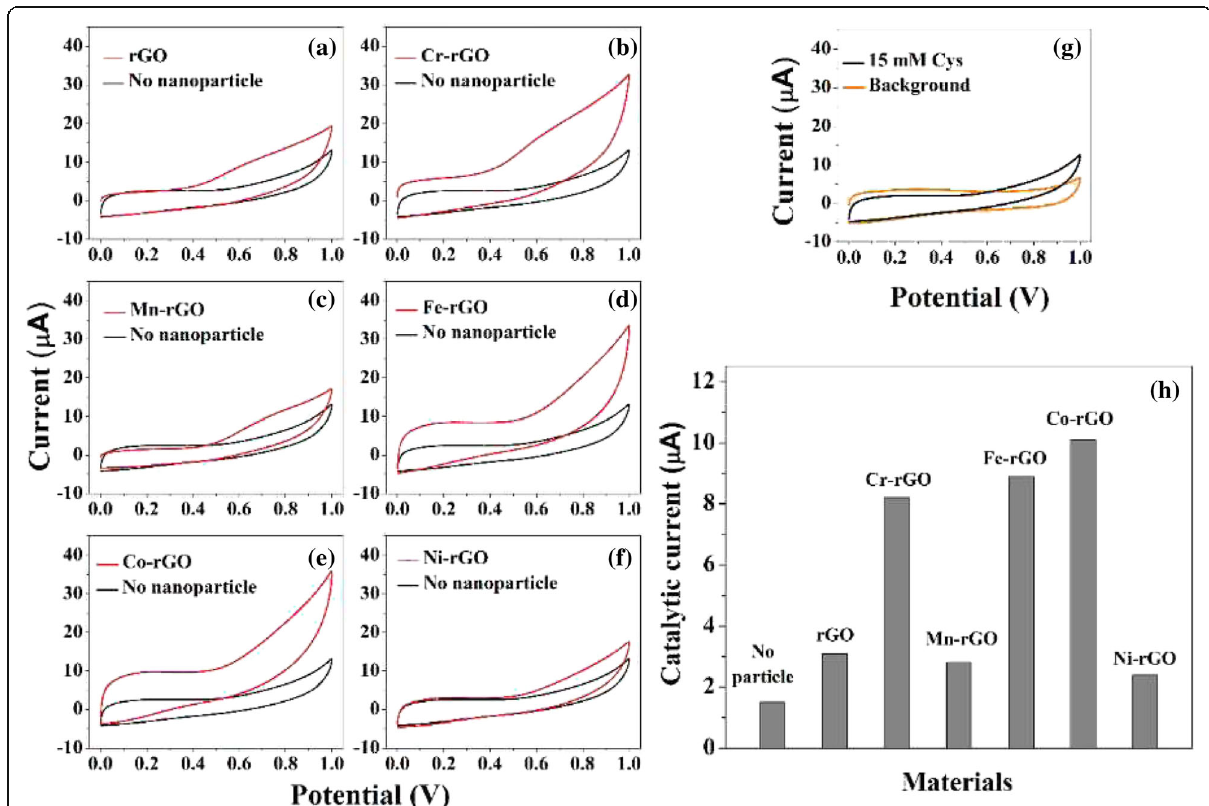
Fig. 2 a – f CV (at a scan rate of 50 mV/s) of 0.015 M Cys solutions in PBS at bare GCEs ( black lines ) and at GCEs modified with 5 wt% a rGO, b Cr- rGO, c Mn-rGO, d Fe-rGO, e Co-rGO, and f Ni-rGO ( red lines ). g The oxidation currents observed at the bare GCEs are sluggish because of the in- trinsically slow oxidation of Cys. h Currents resulting from the electrochemical oxidation of Cys in the presence of pristine rGO and the five TM-rGO